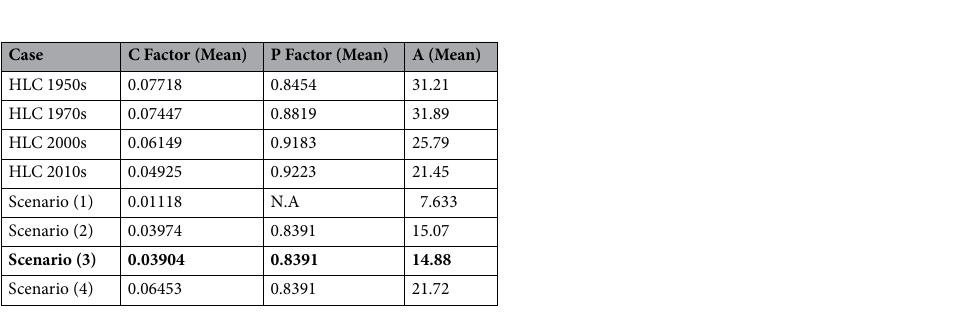
Table 3. A, C and P factors’ mean values of the HLC—RUSLE models compared with the four simulated case- limit scenarios. The values of Scenario 3 are in